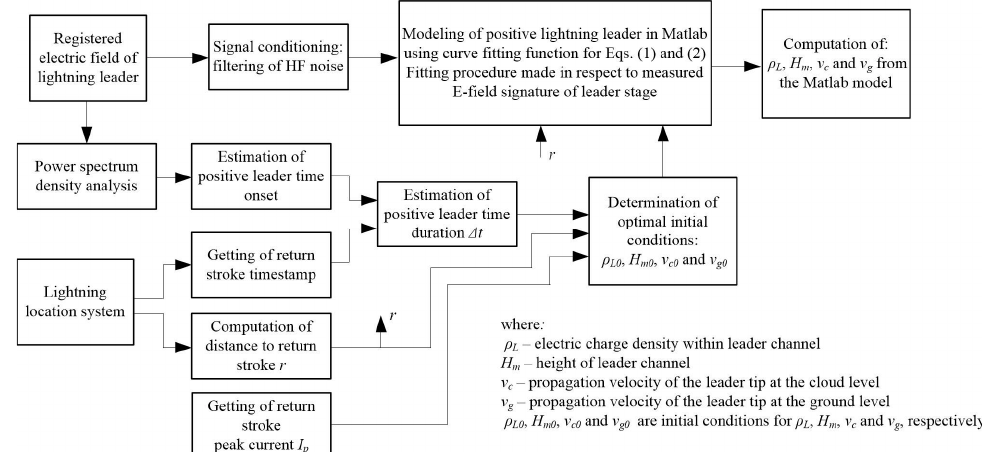
Figure 2. Block diagram for proposed method of modeling leader stage in positive CG lightning. The proposed model of a positive lightning leader is based on Equation (1), which corresponds to the formula for the vertical component of an electric field E z from a negative downward leader given by Rakov and Uman [1]: 𝜌 (cid:3013) (cid:4666) 𝑟, 𝑡 (cid:4667) = − 𝐸 (cid:3027) 2𝜋𝜀 𝑟 (cid:2868) where ρ L is the linear charge density in C/m deposited along the vertical leader channel, ε 0 is the electric permittivity of a vacuum assumed as 8.84 × 10 − 12 F/m, r is the horizontal distance to the leader channel in m, H m is the leader channel height given in m and z t is the height above ground of the stepped leader tip in meters at the time t , given in seconds. The geometry of the model is presented in Figure 3.